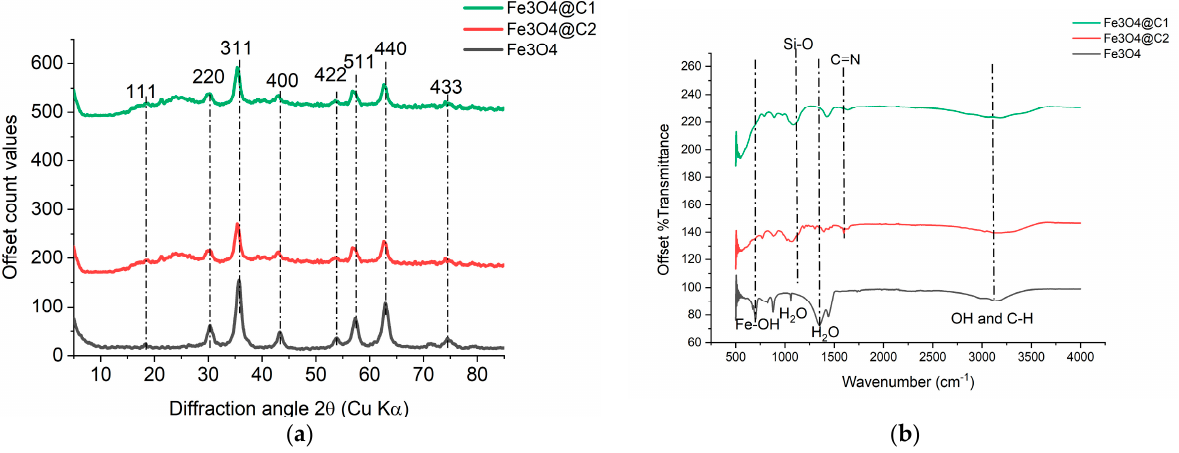
Figure 2. Powder X-rays diffraction patterns ( a ) and FTIR spectra ( b ) of magnetite (Fe 3 O 4 ), Fe 3 O 4 @C2 and Fe 3 O 4 @C1 .